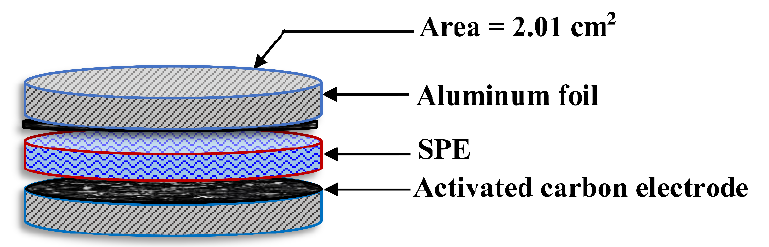
Figure 2. Schematic diagram of the electrical double-layer capacitor (EDLC) cell used in the charge-discharge measurement.